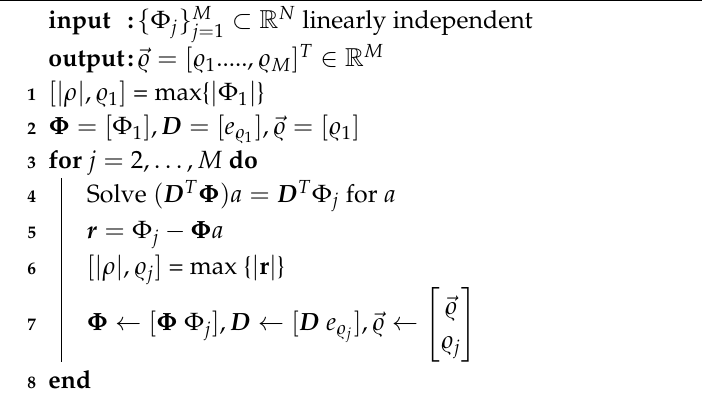
Algorithm 2: Discrete Empirical Interpolation Method